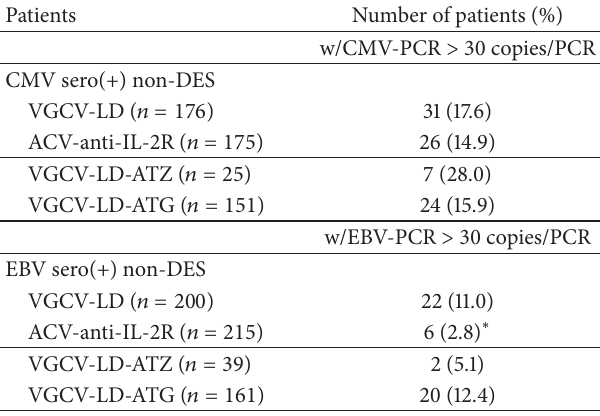
Table 5: CMV and EBV viremia in sero(+) non-DES patients who received valganciclovir (VGCV-LD) versus acyclovir prophylaxis